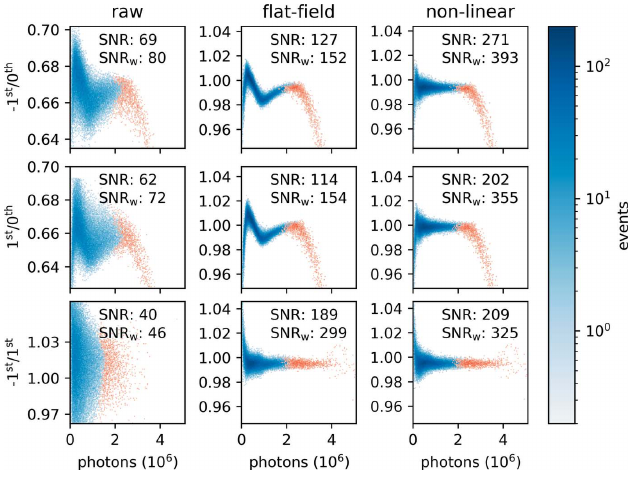
Figure 5 Two-dimensional histograms of the three ratios ( (cid:2) 1st/0th grating order in the top row, 1st/0th in the middle row, and (cid:2) 1st/1st in the bottom row) as a function of the number of photons in the 0th order for dark-corrected data in the left ‘raw’ column, for the dark-corrected and flat-field- corrected data in the middle ‘flat-field’ column, and finally for the dark- corrected, flat-field-corrected and non-linear-corrected data in the right ‘non-linear’ column. Data that contain saturated pixels are shown as red, as opposed to blue where no saturation occurs. In each plot, the SNR and weighted SNR (SNR w ) of the non-saturated events are